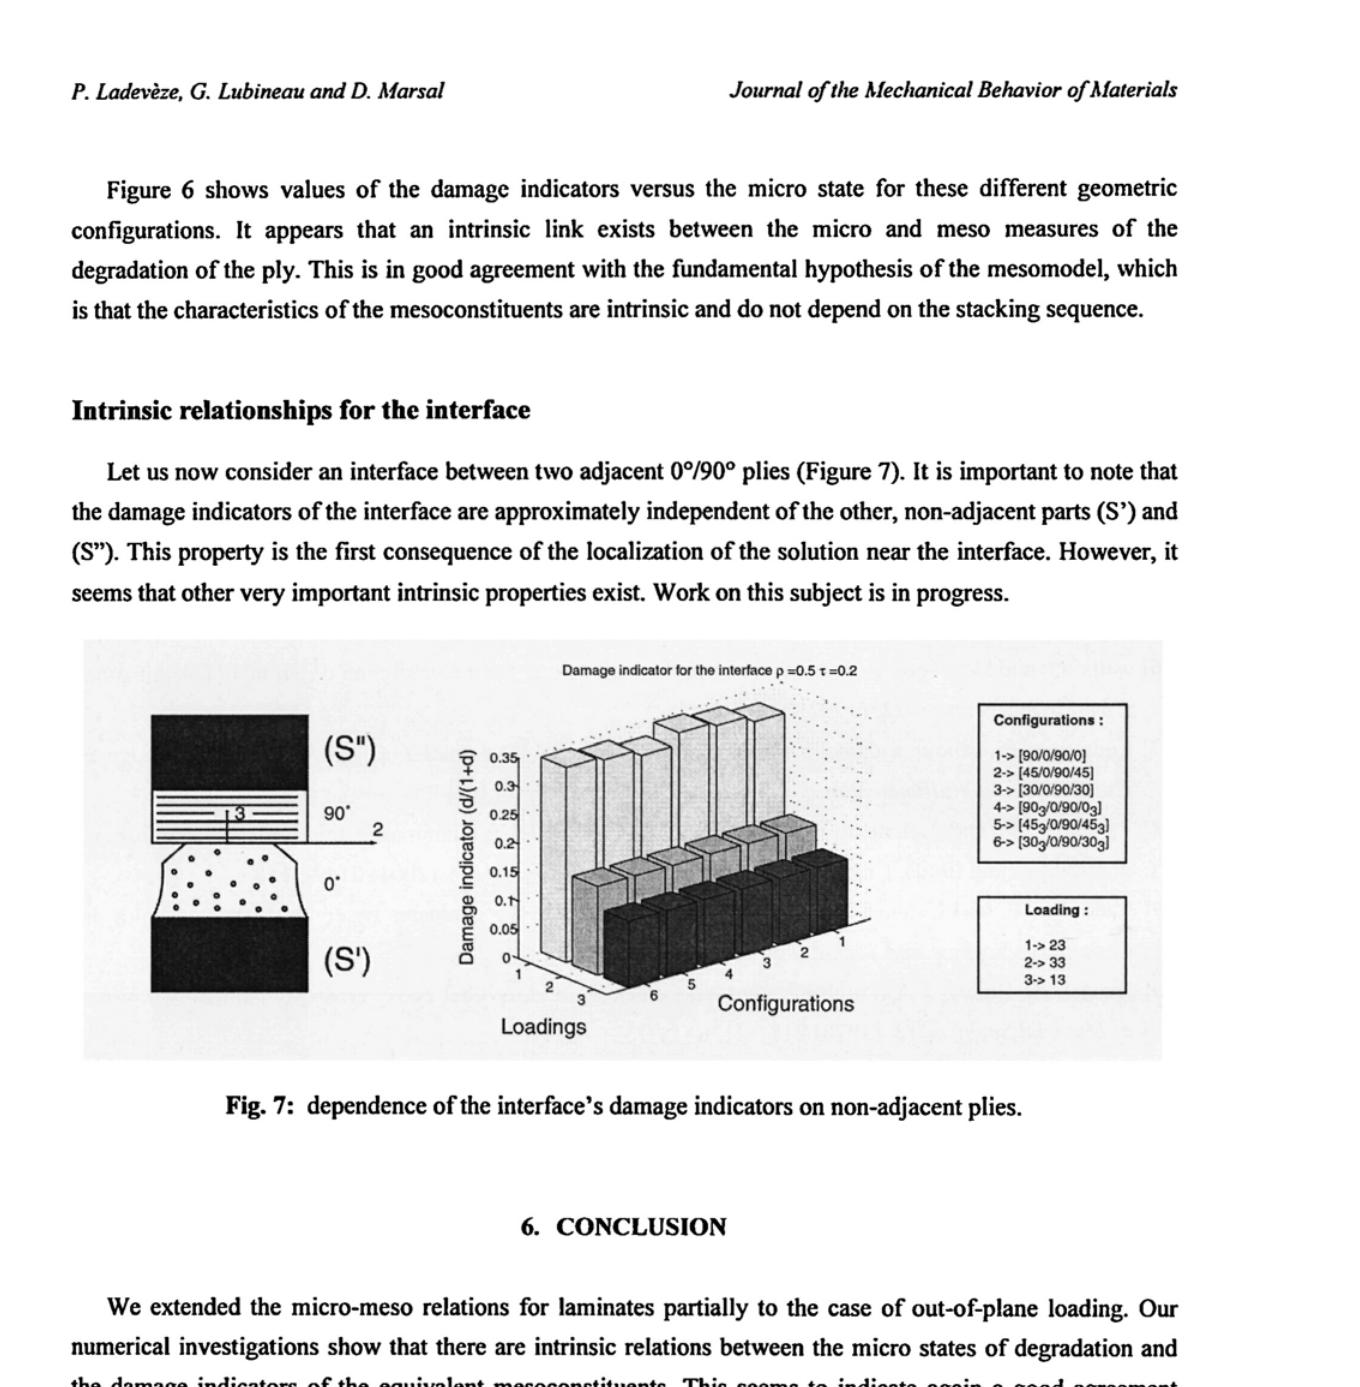
Fig. 7: dependence of the interface's damage indicators on non-adjacent